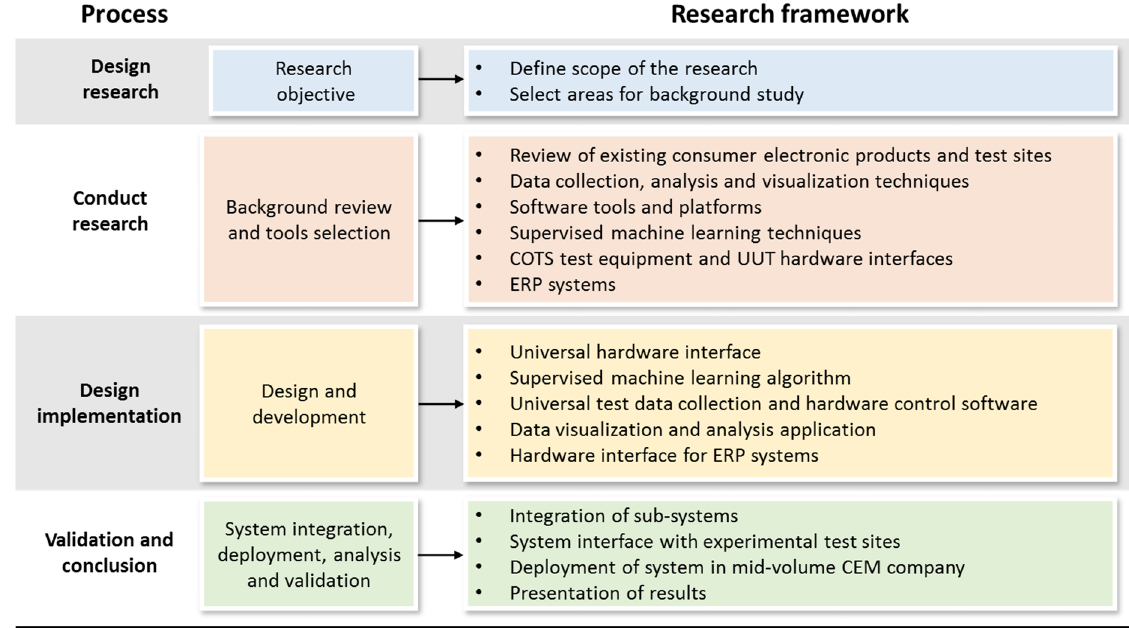
Figure 3. Research methodology.